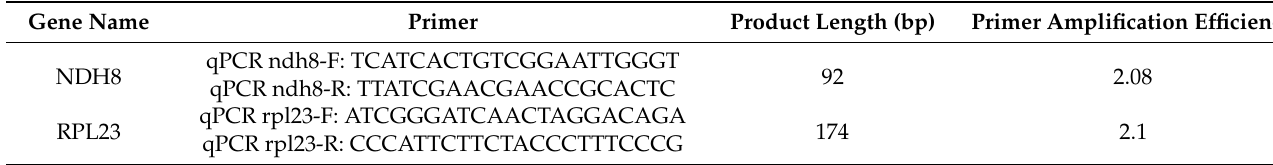
Table A1. Primer information for fluorescence quantitative polymerase chain reaction.